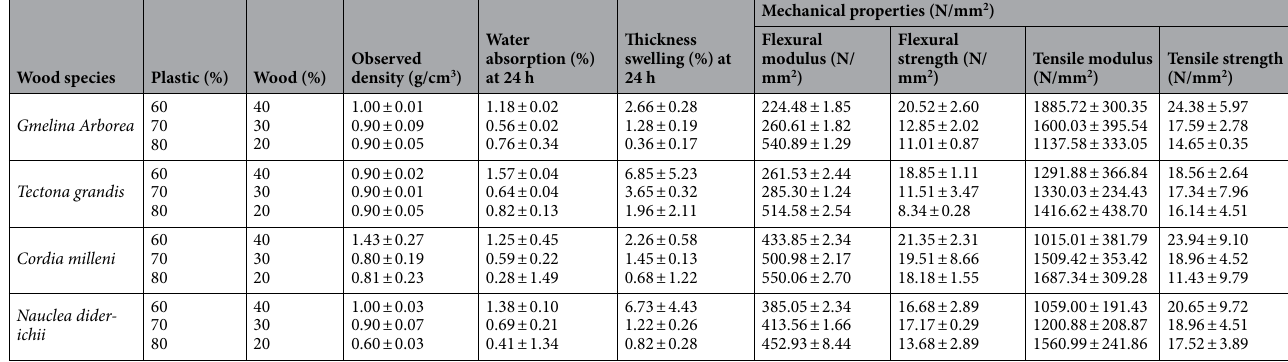
Table 1. Mean values obtained for physicomechanical properties of extruded-compressed biopolymer composite. Each value represents the mean of five replicates with standard deviations.